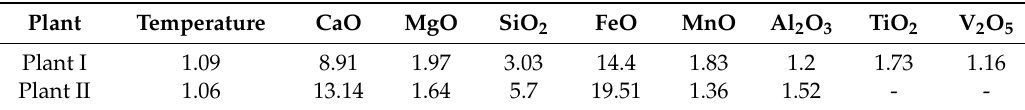
Figure 6. Observation vs. Index Plot for ( a ) plant I and ( b ) plant II. Table 3. Variance Inflation Factor (VIF) values corresponding to Predictors used to model data from plant I and plant II.